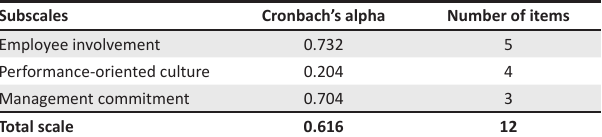
TABLE 1: Cronbach’s alpha for three subscales of the effectiveness of the performance management system scale. Subscales Cronbach’s alpha Number of items